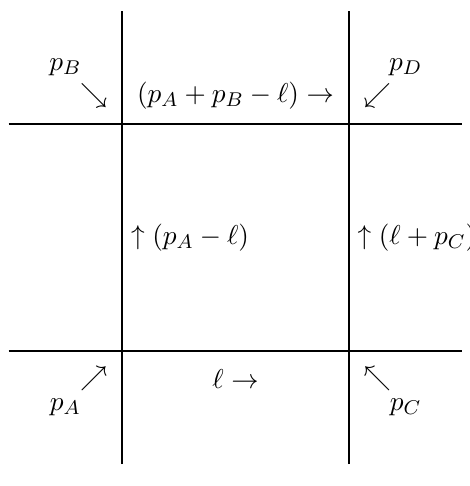
Figure 1 . The box diagram of the eight point amplitude in (cid:30) 4 theory. The external momenta p A ; p B ; p C ; p D entering at the four vertices are taken to be positive if ingoing. space-time dimension D = d + 1 will be chosen such that the box diagram of (cid:12)gure 1 has no ulltra-violet divergence. This requires D (cid:20)